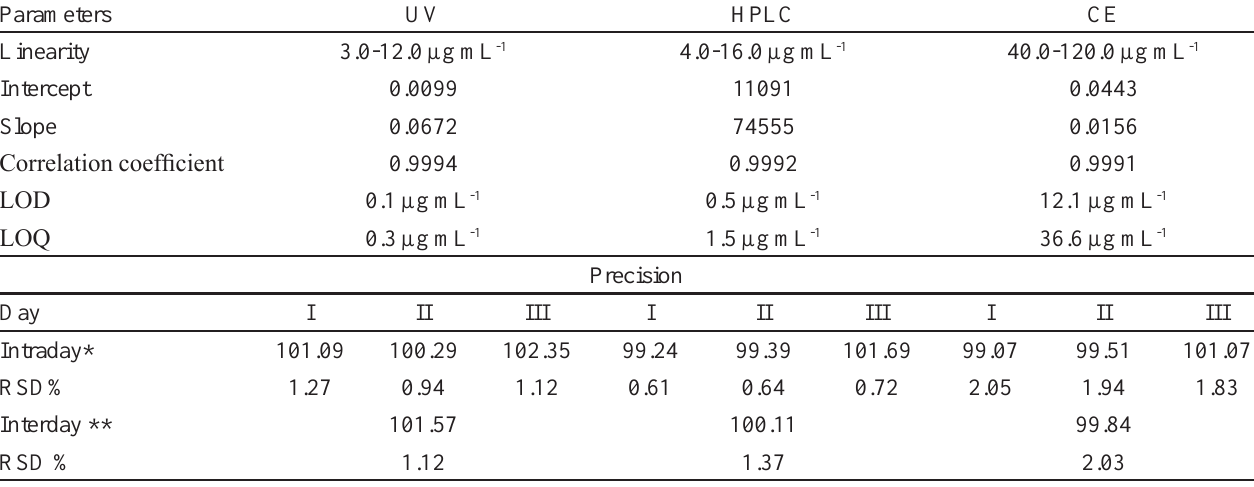
TABLE II - Linearity and precision of UV, HPLC and CE methods for quantification of hydrochloride raloxifene in tablets Parameters